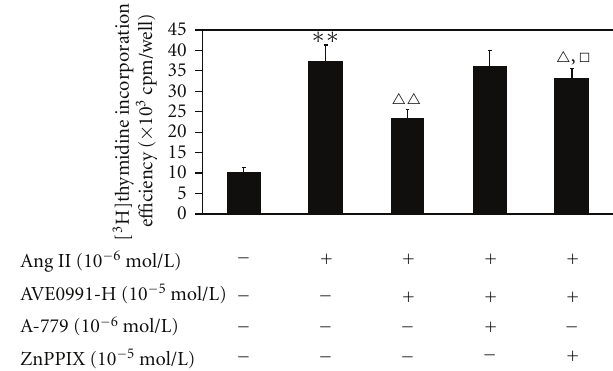
Figure 3: The e ff ect of AVE0991 on the [ 3 H]thymidine incorpora- tion e ffi ciency of VSMCs that were stimulated by Ang II. ∗ P < 0 . 05; ∗∗ P < 0 . 01 versus control group; (cid:5)(cid:5) P < 0 . 01 versus Ang II group; (cid:2) P < 0 . 05 versus Ang II + AVE0991-H group; n = 8.